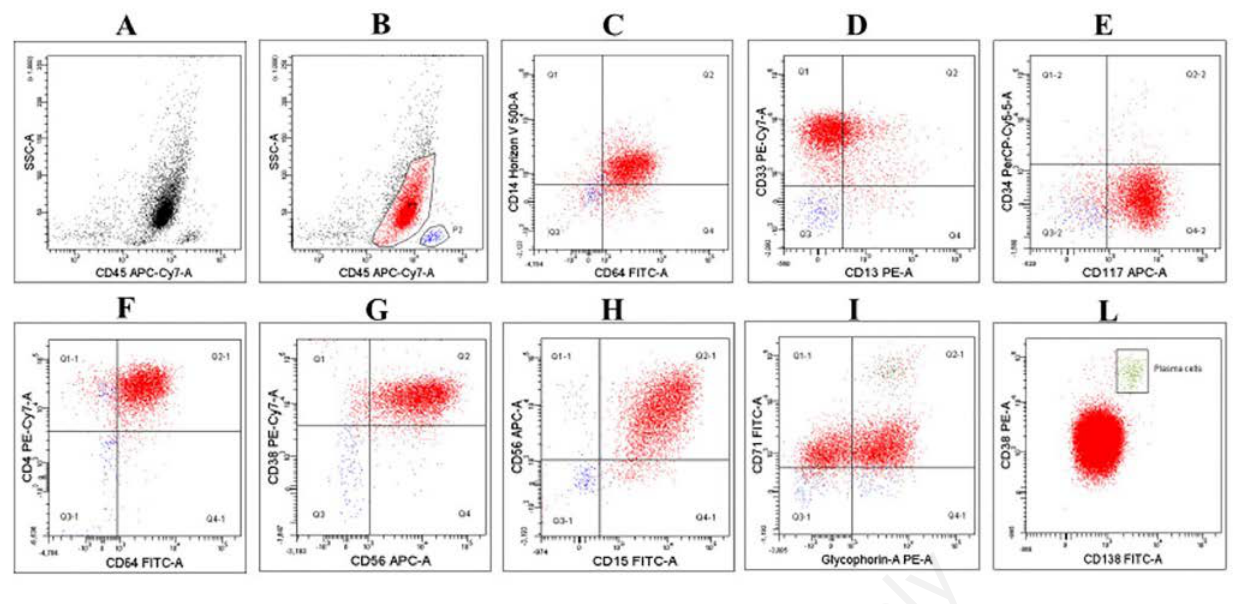
Figure 3. Flow cytometric immunophenotyping of bone marrow, quadrant analysis. A) CD45/SSC properties of blast cells. B) gating of blast cells (P1, red dots) and residual lymphocytes (P2, blue dots). C-H) pattern of expression of monocytic and myeloid markers. I) co-expression of CD71 (with low fluorescence intensity) and Glycophorin-A (which is positive in 60% of blast cells). L) detection of a very small plasma cell